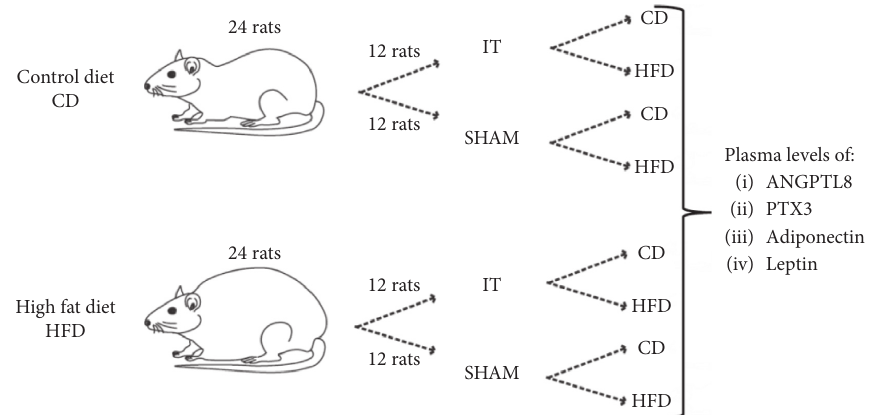
Figure 1: Scheme of experimental groups.